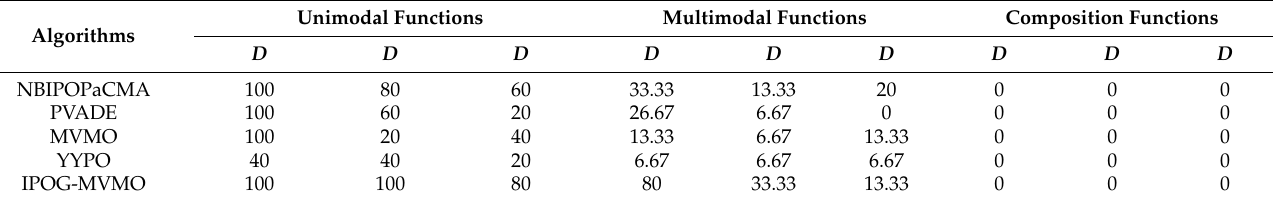
Table 9. Likelihood of obtaining zero error in 50